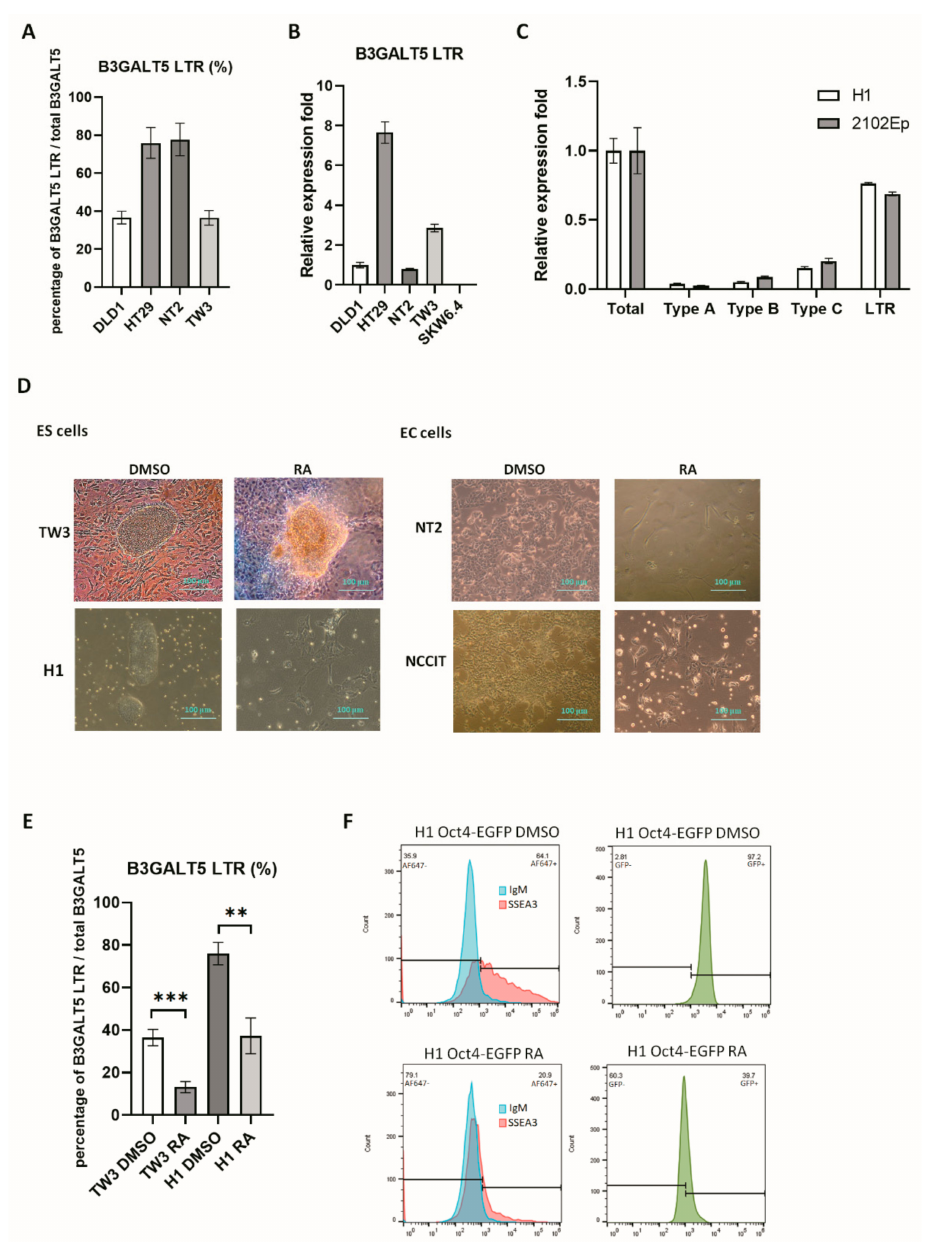
Figure 1. B3GALT5 -long terminal repeat (LTR) expression in embryonic stem (ES) and embryonal carcinoma (EC) cell lines. ( A ) The expression of B3GALT5 -LTR compared with that of total B3GALT5 in colon cancer cell lines (DLD1, HT29), an EC cell line (NT2), and an ES cell line (TW3), reported as a percentage. ( B ) Normalized expression of B3GALT5 -LTR in the cell lines is shown in Figure 1A and in a B-lymphoid cell line (SKW6.4). The DLD1 cell line amount was set to one. ( C ) Normalized expression of all B3GALT5 transcripts in H1 and 2102Ep cells. Specific primers designed to amplify the B3GALT5 coding region were used to quantify the total transcripts. Three native promoters with their own specific exon were used to design specific primers to quantify as Type A-C transcripts. B3GALT5 -LTR transcript levels were higher than Type A-C transcripts. ( D ) Morphology of the undi ff erentiated and the retinoic acid (RA)-induced di ff erentiated ES and EC cell lines. ( E ) Reduction of B3GALT5 -LTR expression in ES cells (TW3 and H1) upon di ff erentiation. ( p < 0.05; **, p < 0.01; ***) ( F ) Octamer-binding transcription factor 4 (Oct-4)-controlled expression of enhanced green fluorescent protein (EGFP) was reduced after RA treatment for one week in H1 Oct4-EGFP cells. Stage-specific embryonic antigen-3 (SSEA3) was also decreased after RA